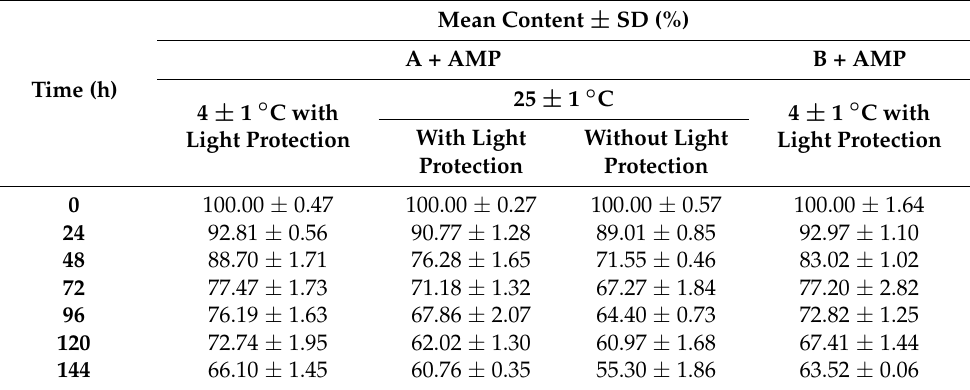
Table 4. AMP content in TPN admixtures during